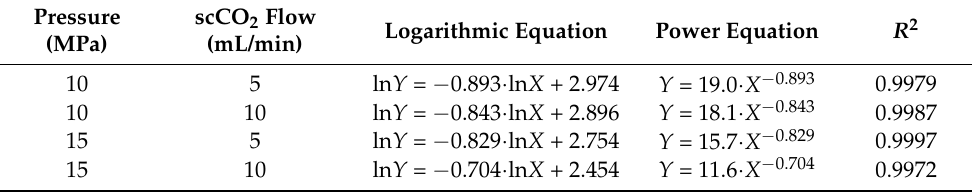
Table 3. Equations describing the relationship between N. sativa oil yield ( X ) and thymoquinone content in oil ( Y ) in different conditions of pressure and scCO 2 flow during extraction at 40 ◦